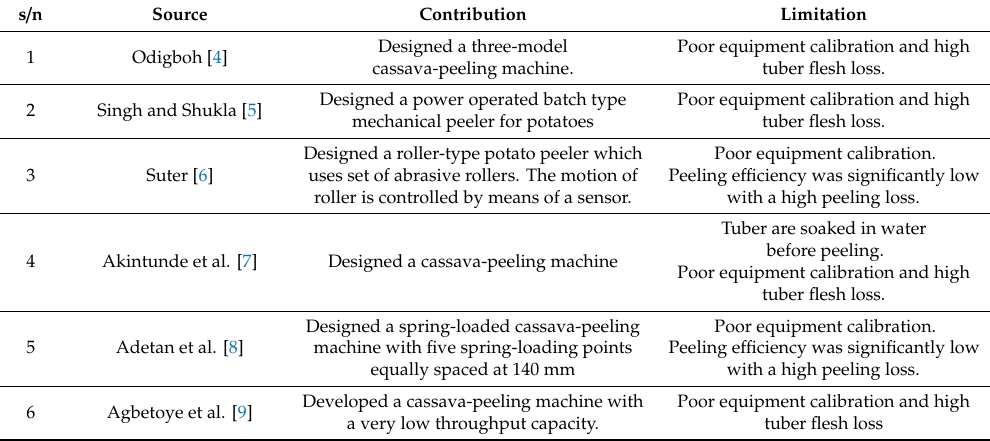
Table 1. Related works, contributions and